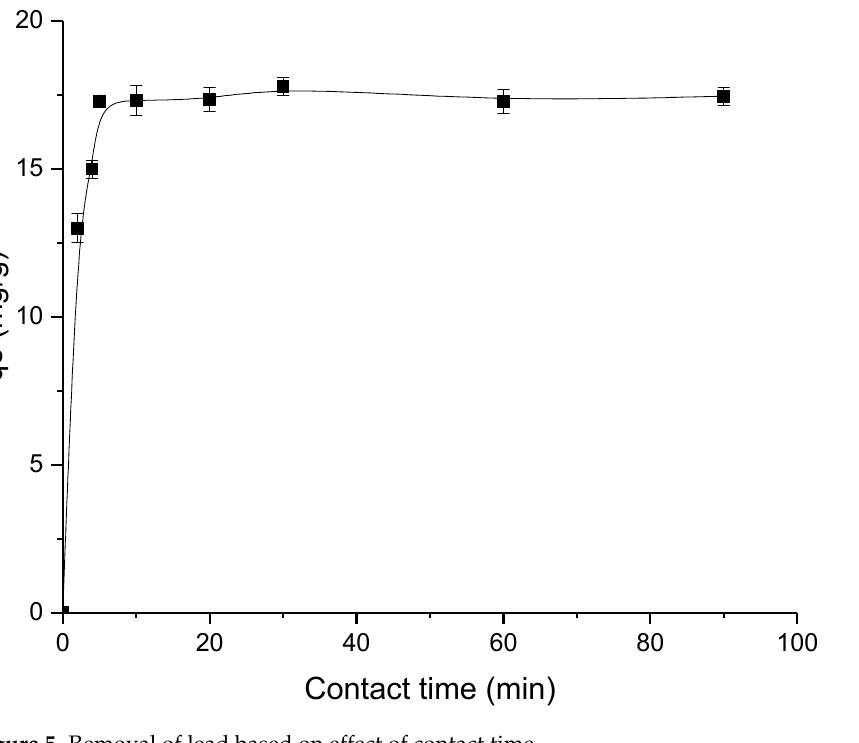
Figure 5. Removal of lead based on effect of contact time. Table 3. Langmuir and Freundlich isotherm parameters for lead adsorption on HAP. Langmuir